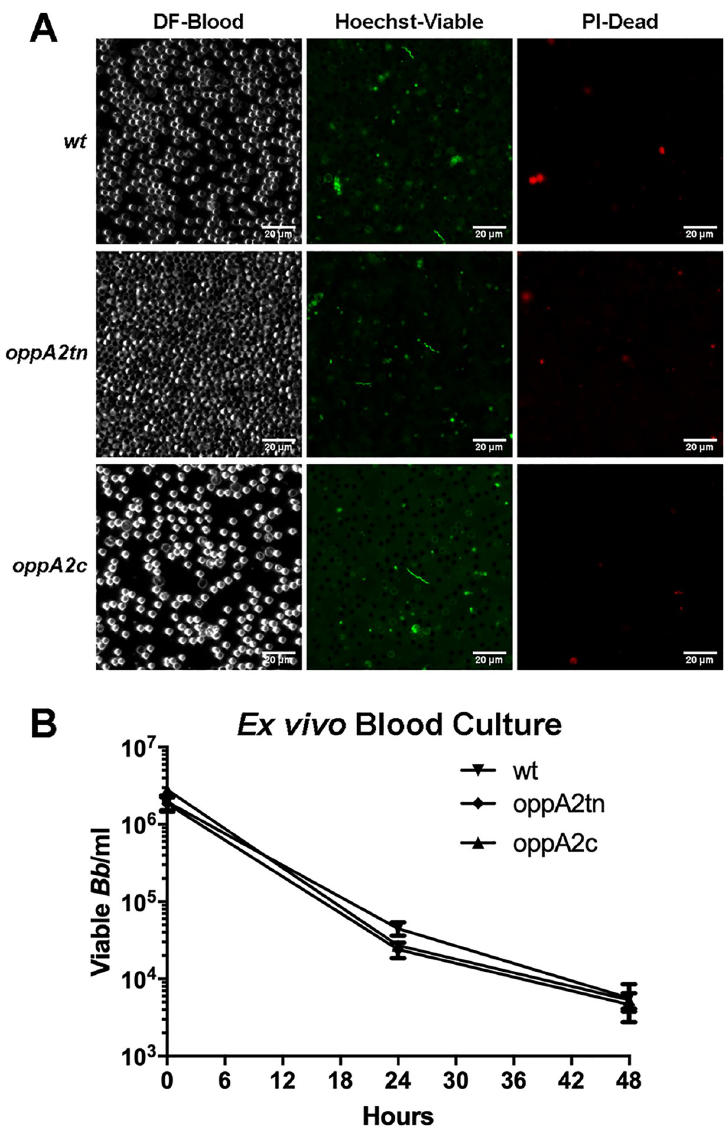
Fig 4. oppA2tn survives comparably to wt during ex vivo blood culture. (A) Darkfield microscopy (DF) and epifluorescence microscopy of Hoechst- (HS—Viable) and propidium iodide-stained (PI–Dead) wt , oppA2tn , and oppA2c spirochetes after 24 hrs ofincubation in whole mouse blood, 400x magnification. (B) Viable spirochetes recovered from blood culture assessed by semi-solid plating at timepoints 0, 24, and 48 hrs.